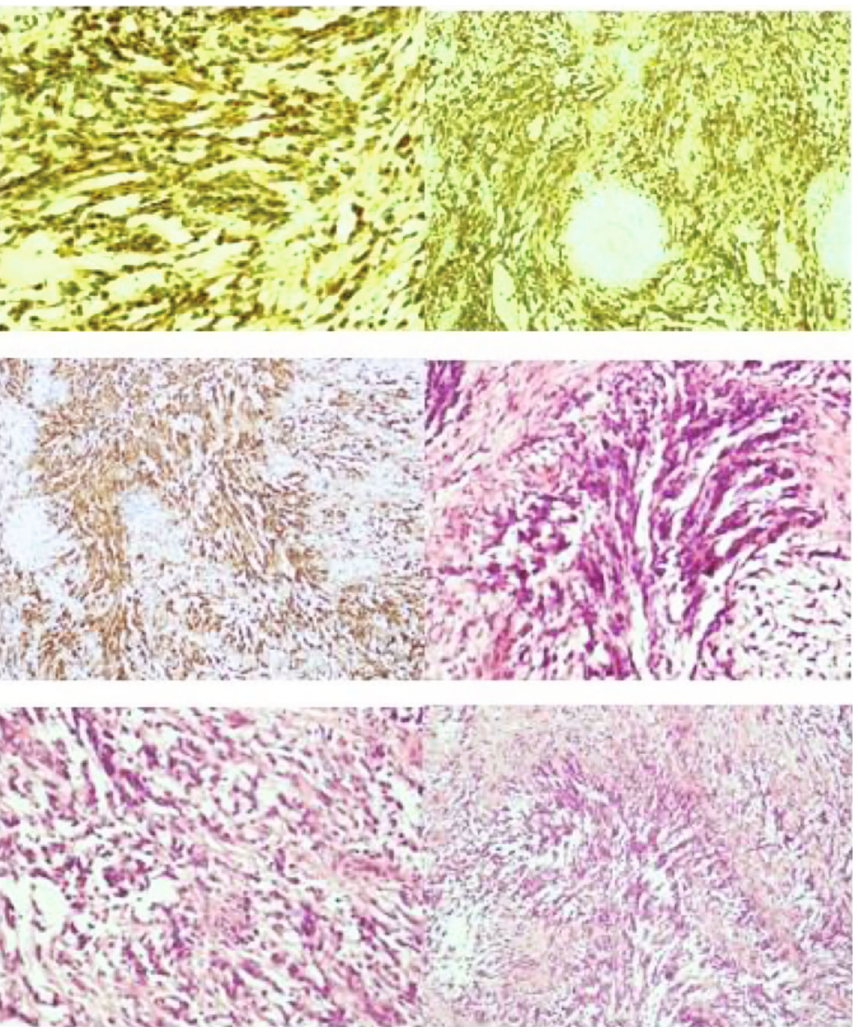
Figure 4: Immunohistochemical positive staining for protein S100 and